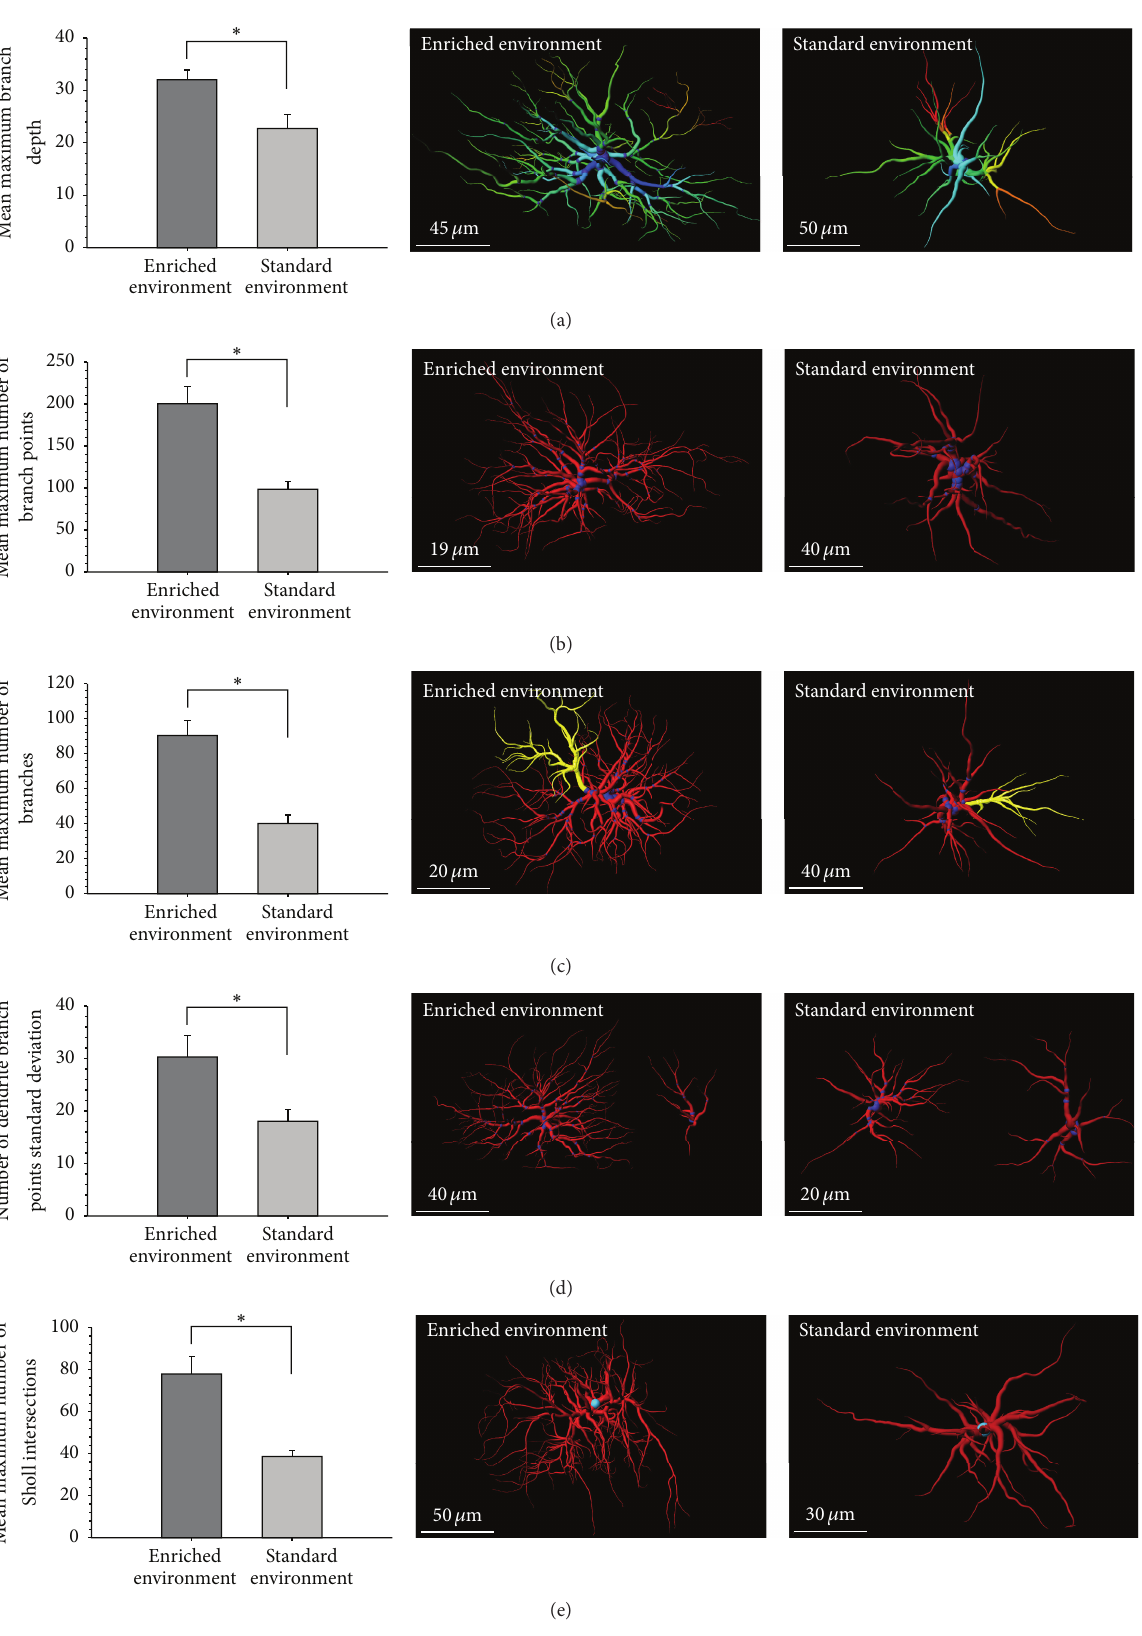
Figure 4: (a) Mean maximum branch depth. (b) Mean maximum number of branch points. (c) Mean maximum number of branches. (d) Standard deviation in the number of branch points. (e) Mean maximum number of Sholl intersections. ∗ denotes a 𝑝 value of <